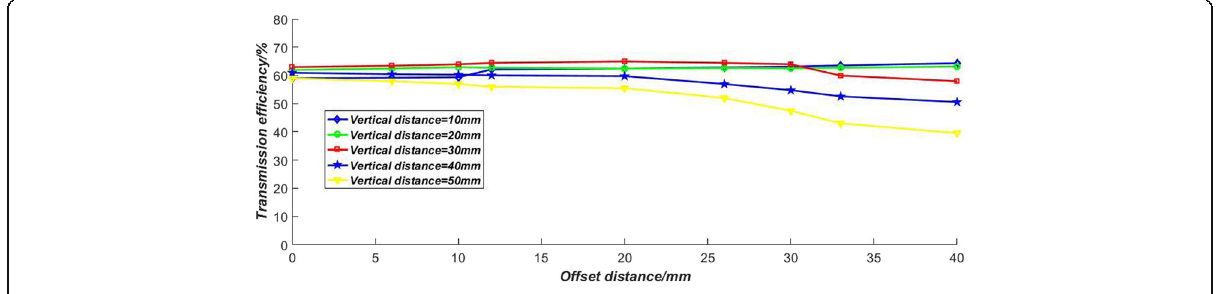
Fig. 18 The transmission efficiency of the WPT system at different vertical